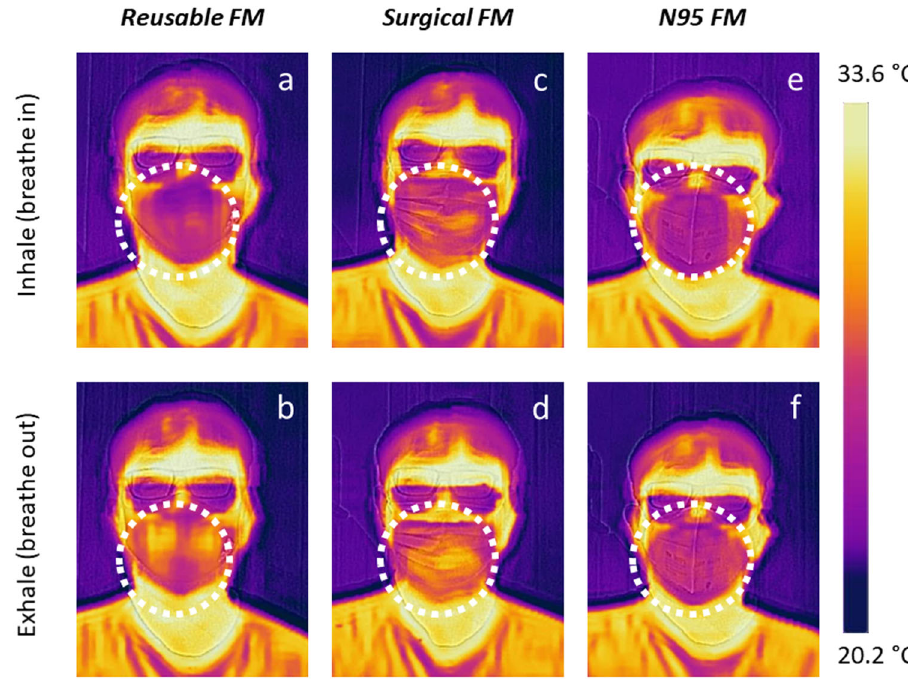
Fig. 5 Evaluation of air transmission (O 2 and CO 2 ) level for three associated face masks by infrared thermal imaging. The thermal images of ¾ portrait are acquired when volunteer breath in ( a , c , e ) and out ( b , d , f ) wearing the reusable ( a – b ), surgical ( c – d ) and N95 ( e – f ) face masks,